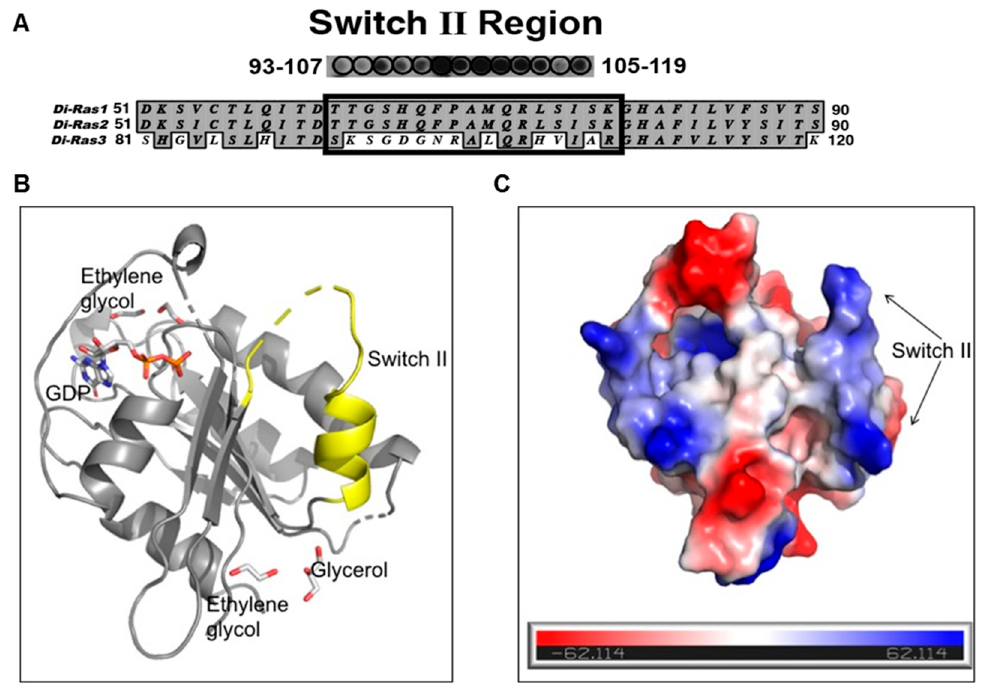
Figure 2. DIRAS2/3 chimera identifies structural confirmation of the switch II region of DIRAS3. ( A ) Peptide array data and sequence alignment of DIRAS of the switch II region responsible for interaction with the N-term of Beclin1. ( B ) Based on the sequence alignment and peptide array data of DIRAS3, we engineered a chimera (on the right) using the crystal structure of DIRAS2 (PDB code:2ERX) as a template. The crystal structure of the chimera is shown in the left panel. The switch II regions are colored in yellow. ( C ) The surface electrostatic potential of DIRAS2/3 chimera protein. Table 1. Refinement statistics for DIRAS2/3 Chimera X-ray crystallography.